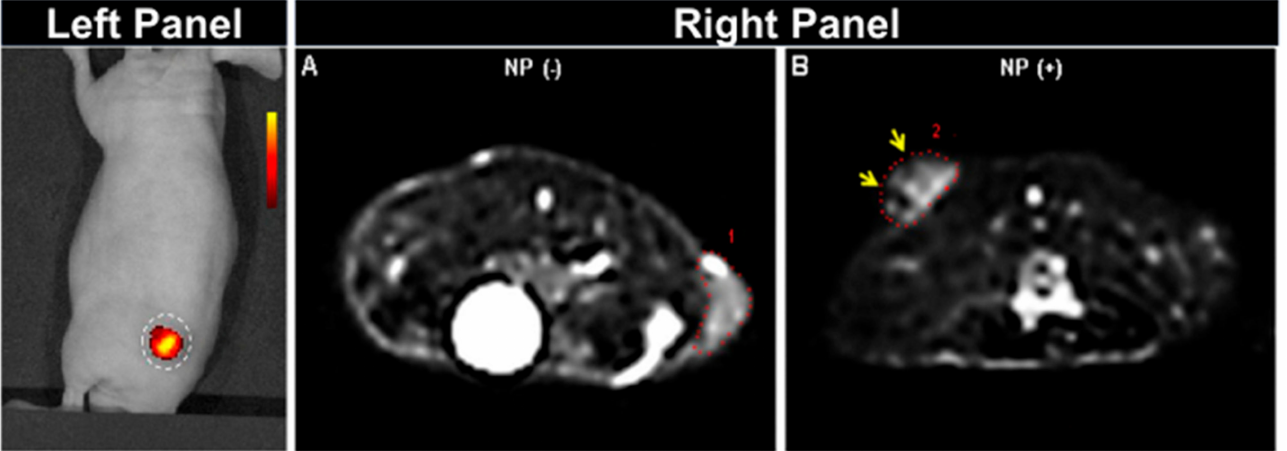
Figure 2. Different imaging modalities on athymic mice demonstrating tumor accumulation of nanocomposites after 24 h of injection. (Left Panel): In vivo NIRF imaging showing fluorescent tumor site, (Right Panel): 3T MRI. Red dotted lines 1 and 2 show the edge of the tumor before ( A ) and after ( B ) nanocomposites administration. Reprinted with permission from ref. [24]. Open Access Creative